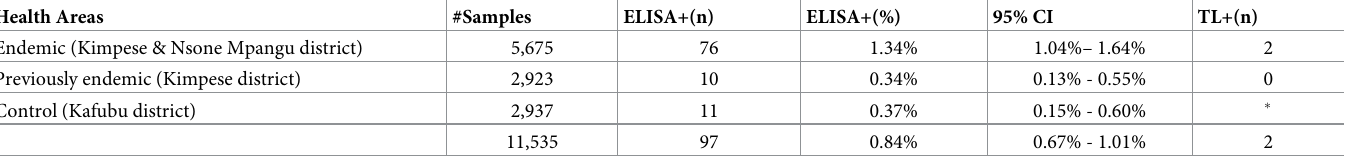
ELISA+: Elisa positive samples, ITL+: Immune Trypanolysis positive samples � ITL analysis was not